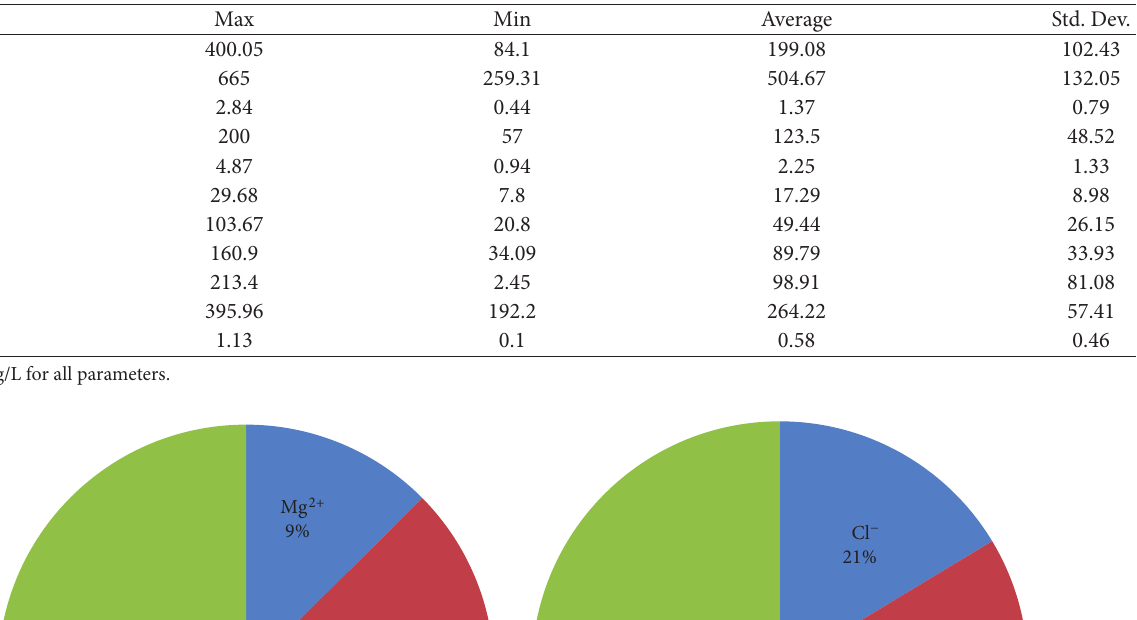
T 1: Statistical analysis for physicochemical parameters of groundwater.